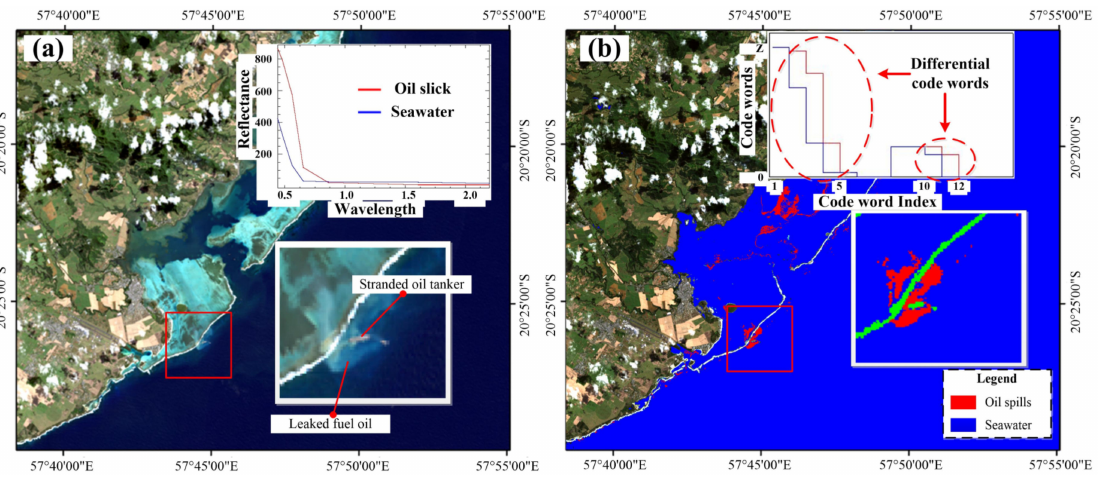
Figure 6. The experimental data 2 (( a ), captured by the Landsat 8 satellite) and its fuel oil leakage detection results produced by the MSE method with SSI ( b ). Differential code words could be observed in the red